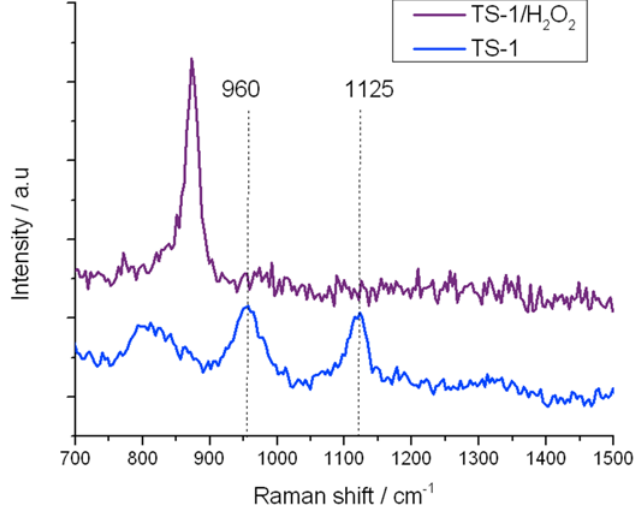
Figure 9. In situ UV-Raman (325 nm) spectra of (blue) TS-1 and (purple) TS-1 treated with H 2 O 2 . Similarly, the residual 960 and 1125 cm − 1 stretches in TS-1B are also eliminated upon treatment with H 2 O 2 , confirming that at least some of the original active site remains following NH 4 HF 2 treatment. However, it is also notable that the 695 cm − 1 band, which has been attributed to the new 270 nm UV-Vis absorbance band, is also eliminated from the Raman spectrum upon coordination of H 2 O 2 . The total loss of this Raman band confirms (i) that this Raman mode arises from a species whose vibrational signature is destroyed upon coordination of H 2 O 2 ; and (ii) that the new active site formed following NH 4 HF 2 treatment reacts with H 2 O 2 , indicating that this species also provides a route toward H 2 O 2 activation. From the characterization data obtained thus far, we assign this change in Ti speciation to the extraction of framework [Ti(OSi) 4 ] atoms, and to the concurrent generation of new active sites. Given that a redistribution of Ti from one T-site to another would not change the intensity of the breathing mode of the [Ti(OSi) 4 ] atoms at 1125 cm − 1 , it is likely that the new active sites are located in extra-framework positions of the